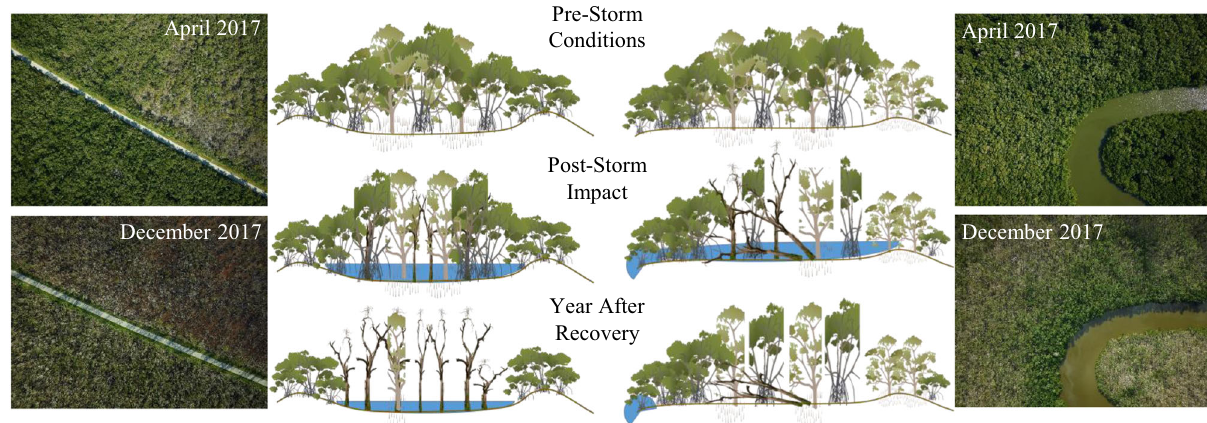
Fig. 4 Forest canopy structure, topographic position, and drainage contribute to differences in mangrove vulnerability and resilience to hurricane damages. a Areas that fl ood from salt water storm surge but do not drain have low resilience, with greatest risk for dieback from hypersalinization and pore water sul fi de build up. b Mangroves in well-drained (i.e., tidally dominated) sites have high resilience to storm damages and can fl ush new leaves or resprout quickly after canopy damage from hurricane winds. Aerial photos from NASA ’ s G-LiHT Airborne Imager show examples of mangroves with low and high-resilience in southwest Florida before and after Hurricane